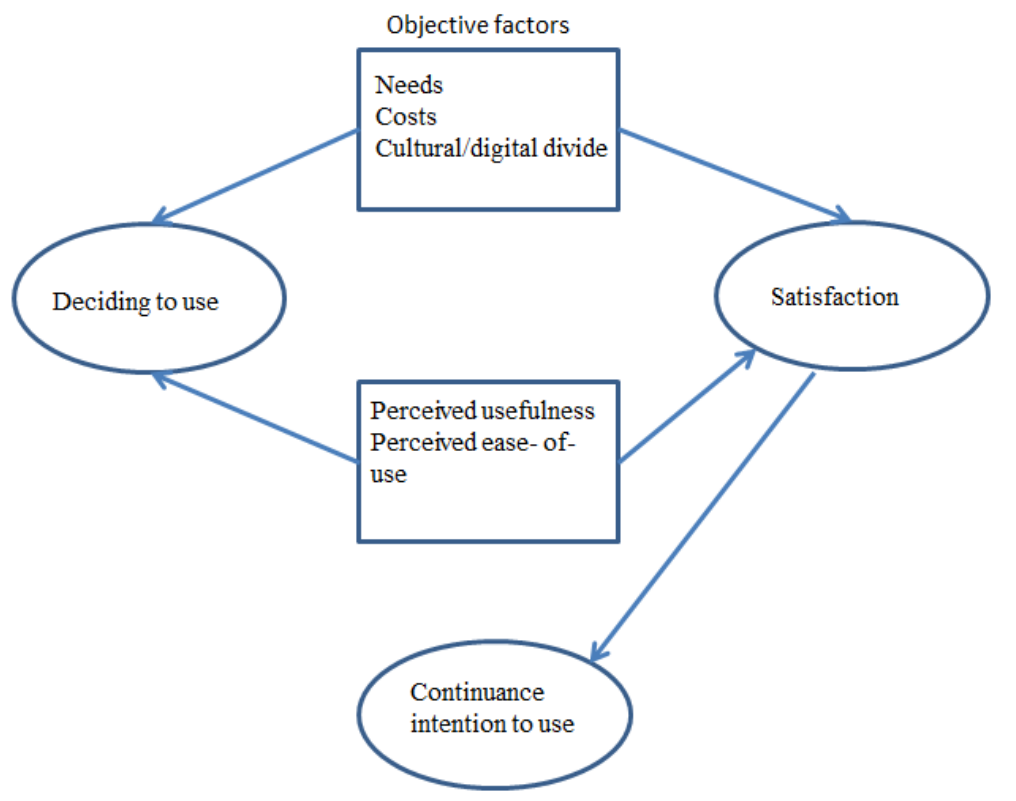
Figure 2. Factors influencing the use of a